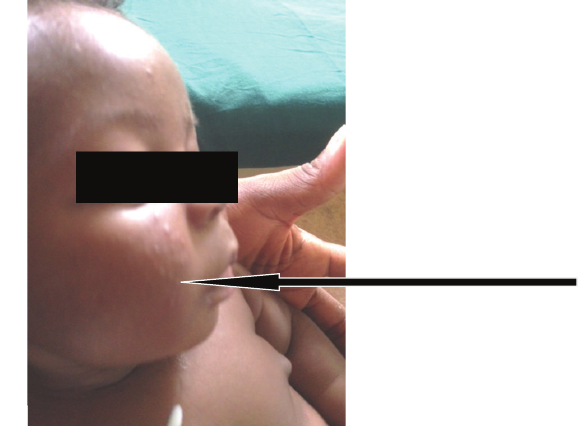
Figure 1: Firm nodular erythematous subcutaneous mass on the face noted on 4th day of life at the newborn nursery.